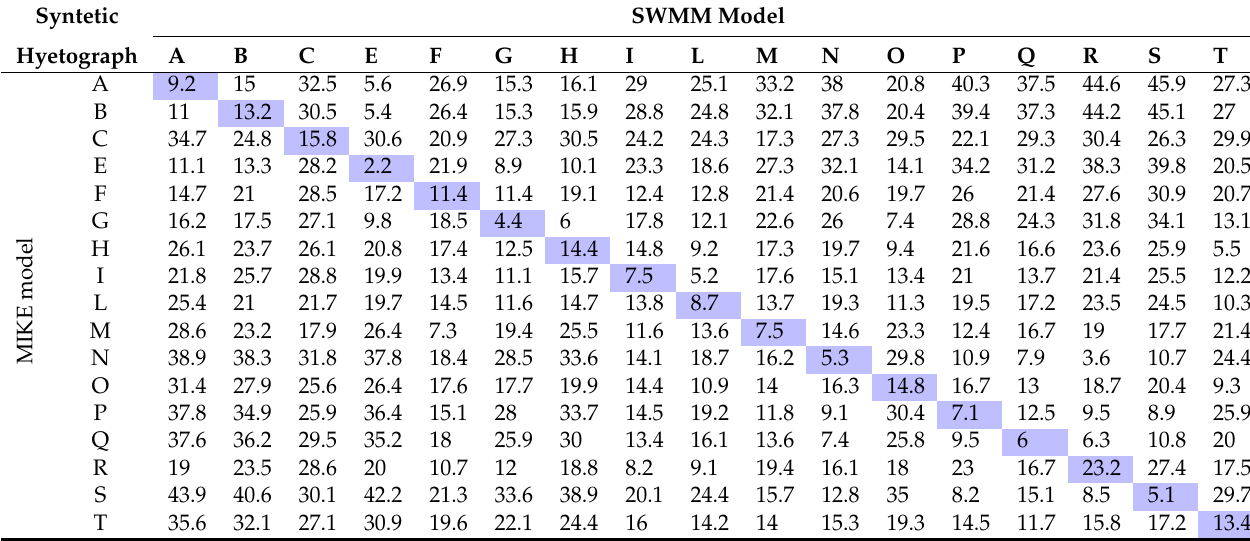
Table 7. Matrix C of the Euclidean distance of the flood maps simulated for 17 rainfall-runoff events using SWMM and MIKE models in the Corace torrent (Calabria, Southern